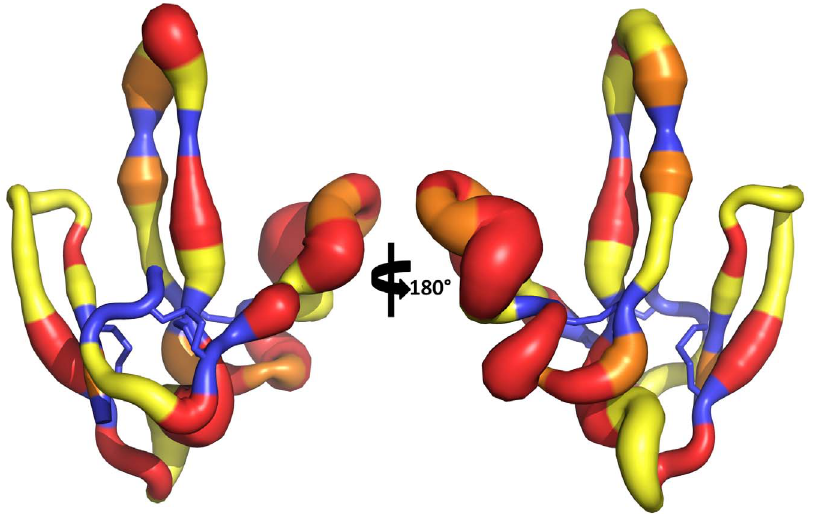
Figure 6. Rates of molecular evolution on PMF-G. Putty model of PMF-G, with backbone width proportional to residue variability (Shannon- Weaver index in Figure 4D), and color-coded according to the likely mode of molecular evolution (based on data from Wilburn et al. [20]; backbone, black; purifying selection, blue; neutral selection, yellow; positive selection, 0.01 # p , 0.05, orange; positive selection, p , 0.01, red).